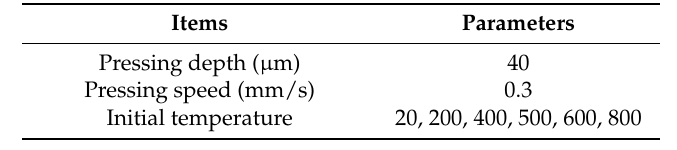
Figure 10. The curve of friction coefficient ( a ) and the relationship between the friction coefficient and load ( b ) All the simulation models needed to have been developed so that the high-temperature hardness simulation could be carried out. High-temperature hardness simulations at different temperatures were performed by importing different initial temperatures, and the design of the simulation is shown in Table 5. Table 5. Design of simulation for high-temperature hardness.